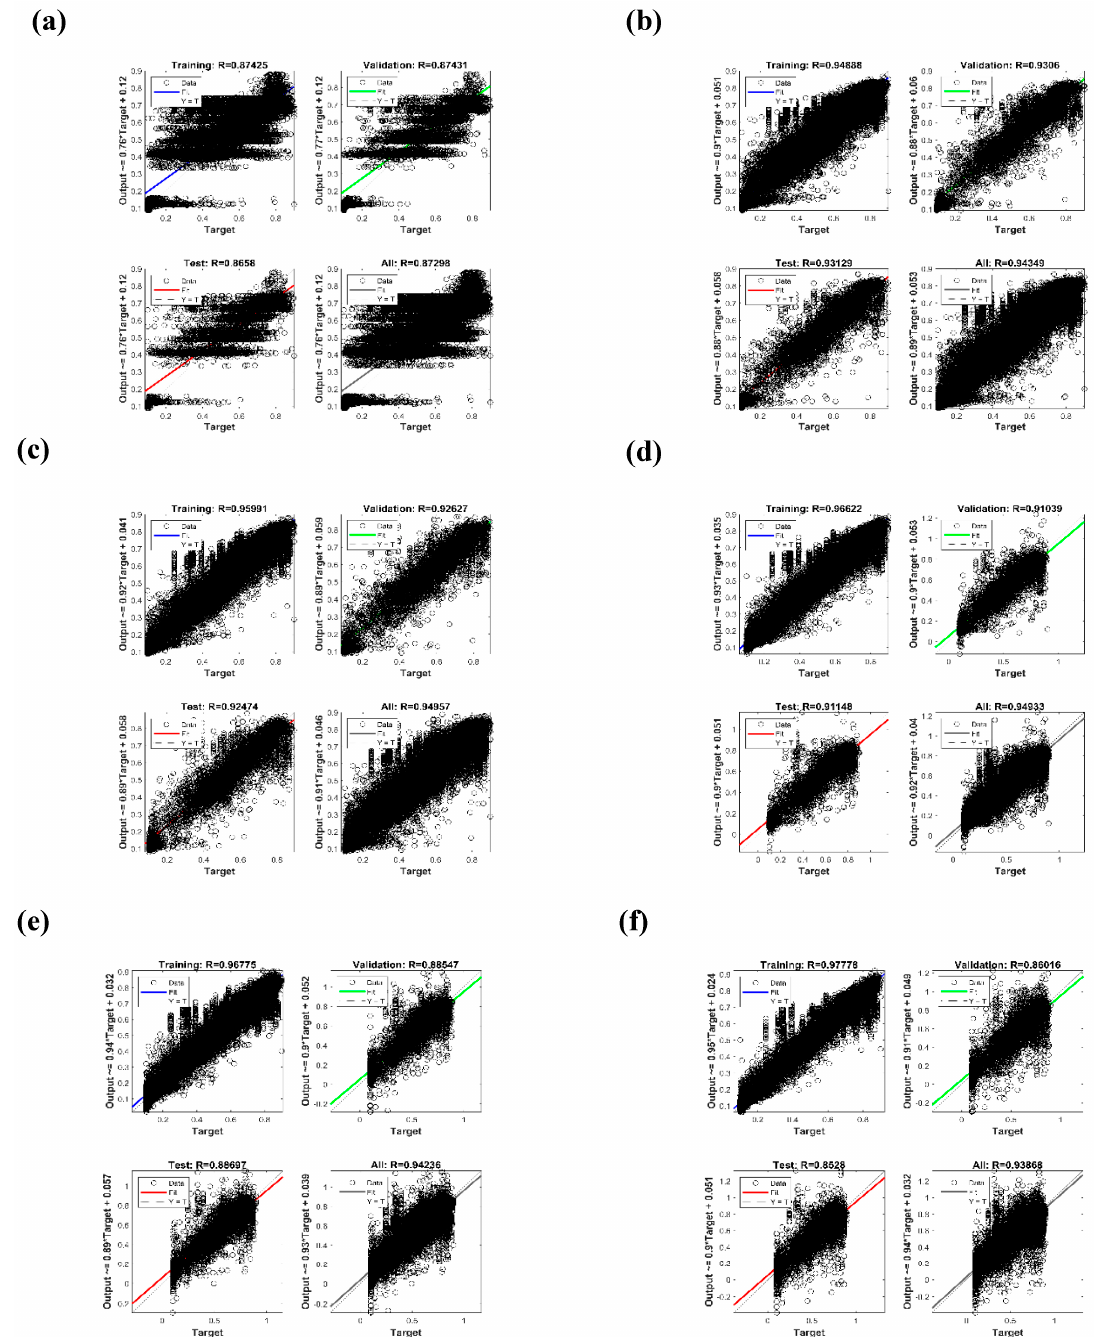
Figure 3. Coefficient of correlation between the dataset and the line of fit for ( a ) 10 hidden units, ( b ) 500 hidden units, ( c ) 1000 hidden units, ( d ) 1500 hidden units, ( e ) 2000 hidden units, and ( f ) 2500 hidden units.